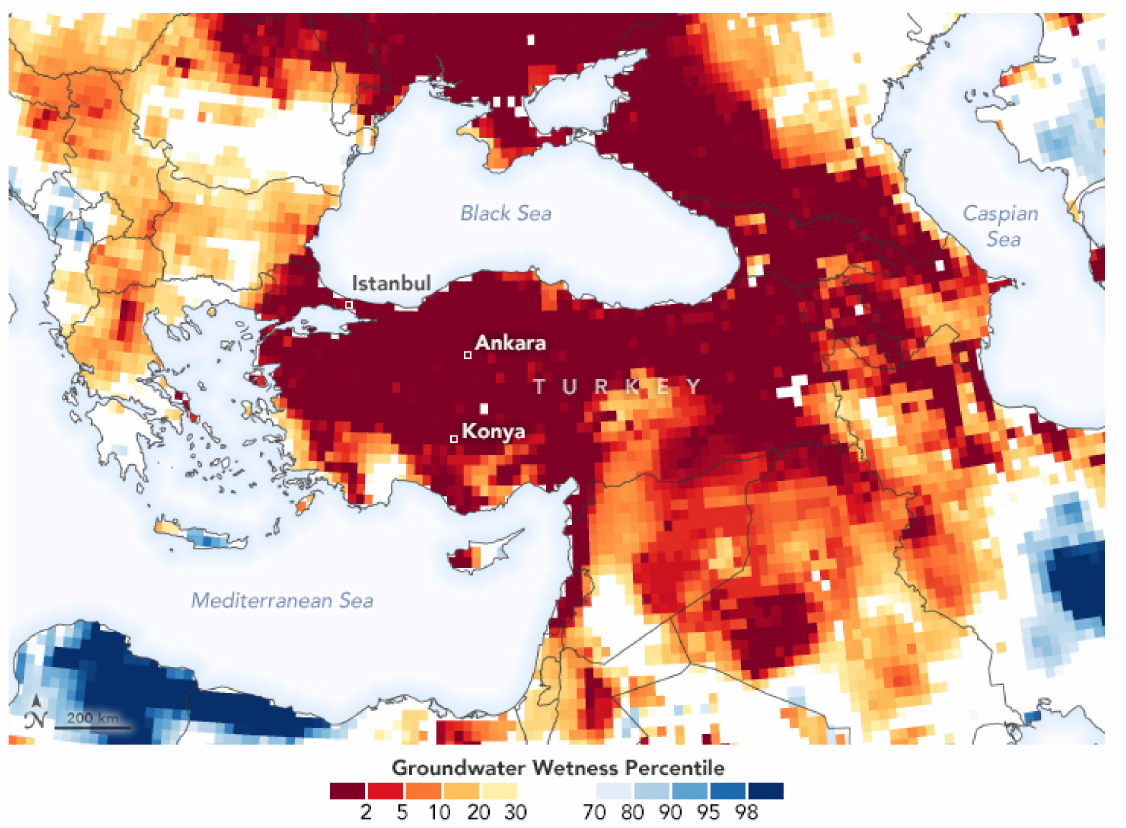
Figure 19. Shallow groundwater storage as of 11 January 2021 in the Black Sea Region and the Middle East, as measured by the Gravity Recovery and Climate Experiment Follow On (GRACE-FO) satellites. The color palette depicts the groundwater wetness percentile, i.e., how the amount of groundwater compares to long-term records (1948–2010). Blue areas have more water than usual, and orange and red areas have less groundwater. Credit: NASA’s Earth Observatory